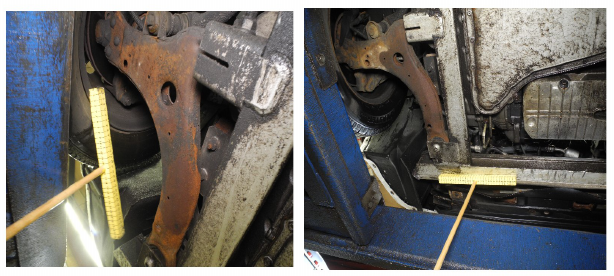
Figure 7. Sample images from dataset 1 consisting of original (unmasked) images.